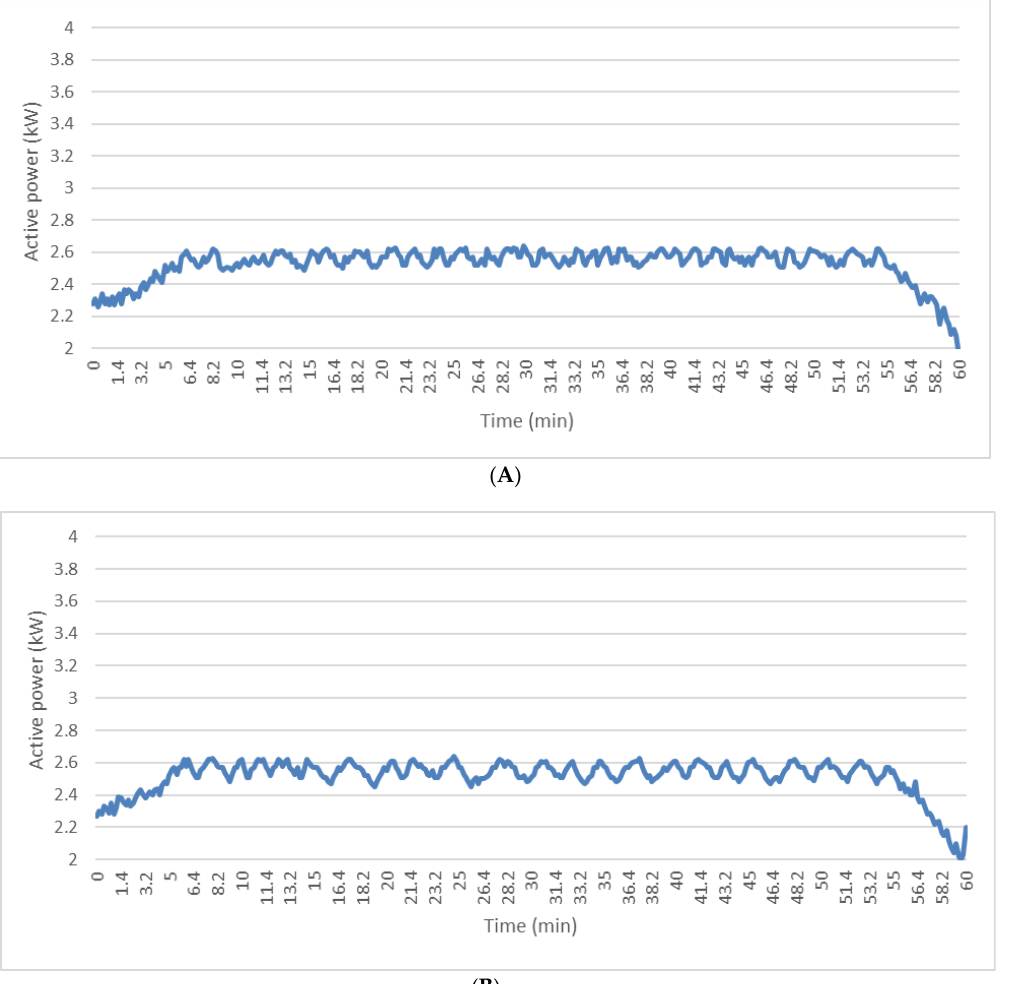
Figure 6. Active electric power absorbed from malaxers as a function of time during the experimental tests. ( A ) Unmodified malaxer and ( B ) modified malaxer.